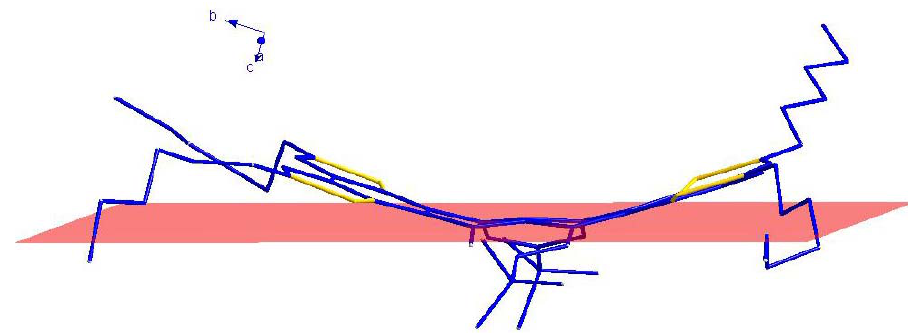
Figure 6. Model of “saddle” shaped THTP-C. An extension of the central plane formed by C22/C15/C11/C18 is shown in red.